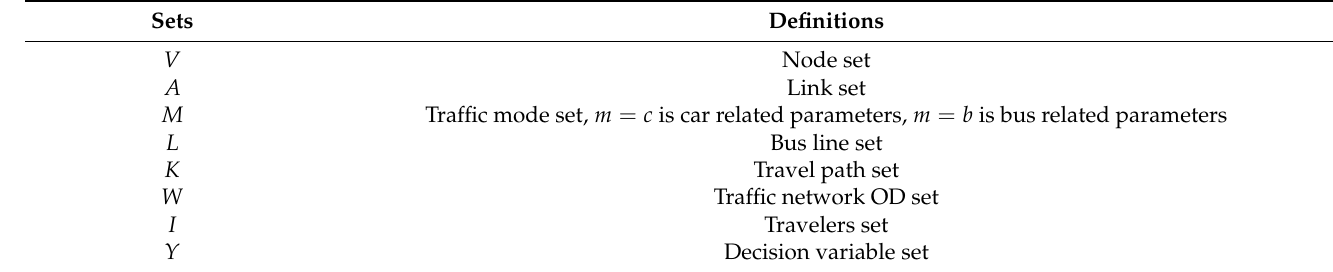
Table 1. Notations and descriptions used in the model.